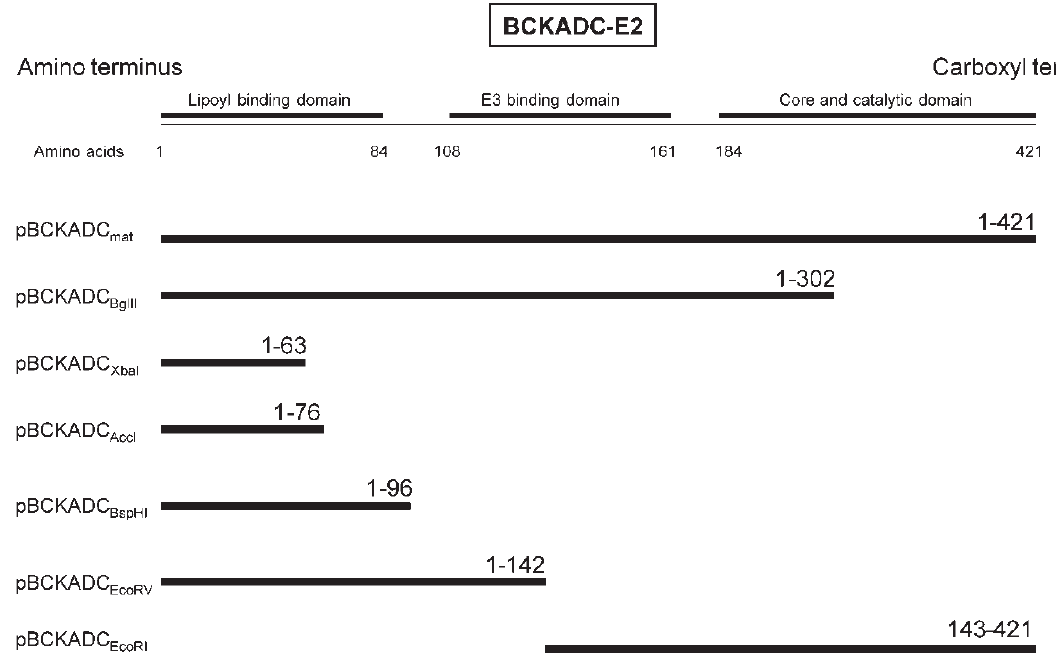
FIGURE 1 Subclones of the complete cDNA encoding the human BCKADC-E2 and its truncated